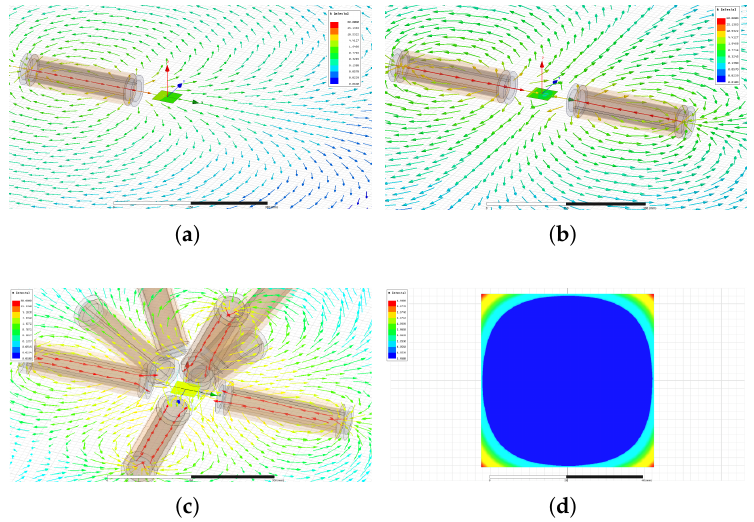
Figure 10. Magnetic field distribution using FEM: ( a ) a single- and ( b ) a dual-electromagnet system; and ( c , d ) the eight-electromagnet arrangement with β i = 0° and β j = 45°. ( d ) The magnetic field magnitude within the workspace.